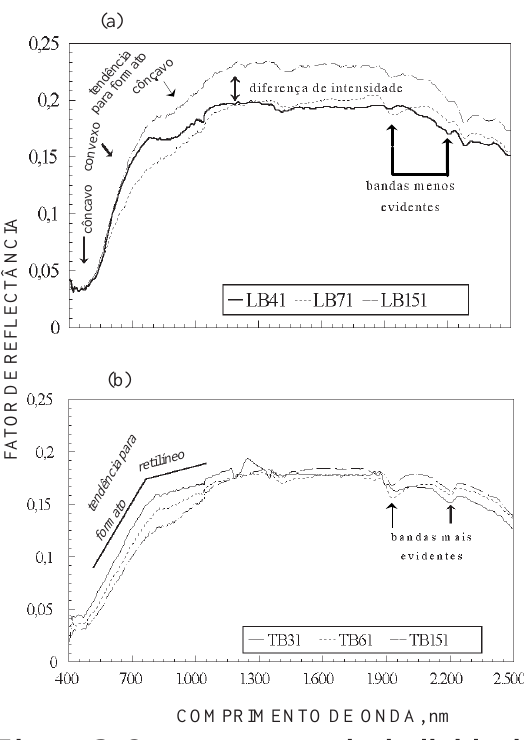
Figura 3. Curvas espectrais individuais de amostras do Latossolo Bruno (LB) e da Terra Bruna Estruturada (TB) da camada de 0-20 cm. Teores de argila (g kg -1 ): LB41 (76); LB71 (61);